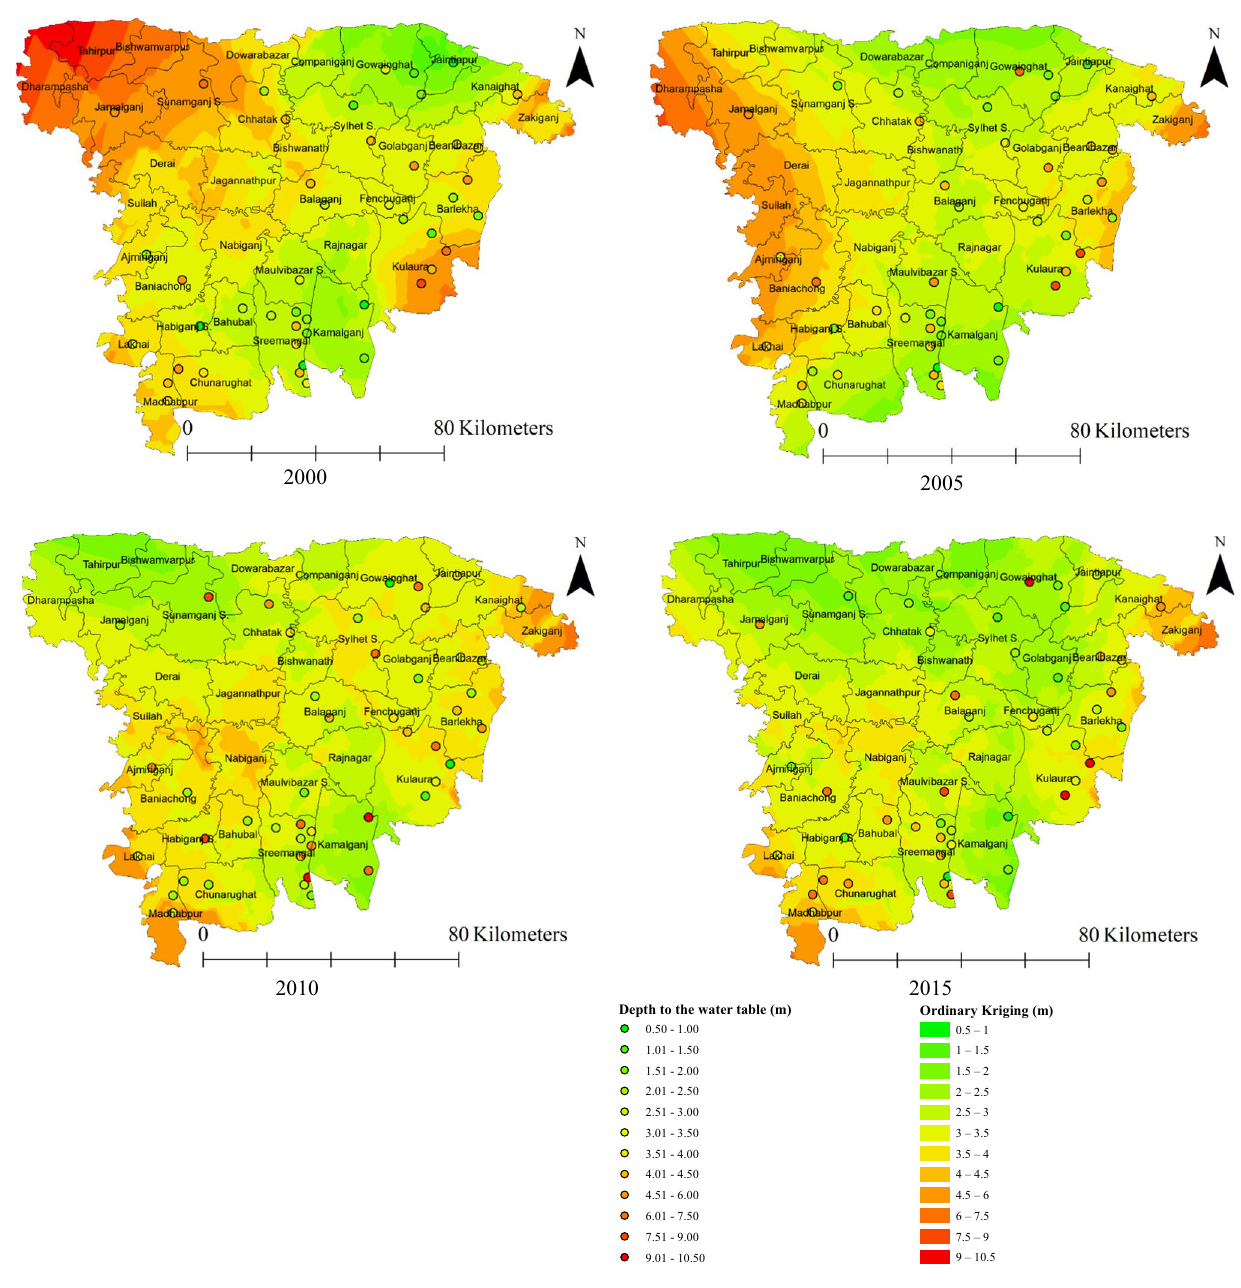
Fig. 7 Spatial distribution map of water table for 2000, 2005, 2010, and